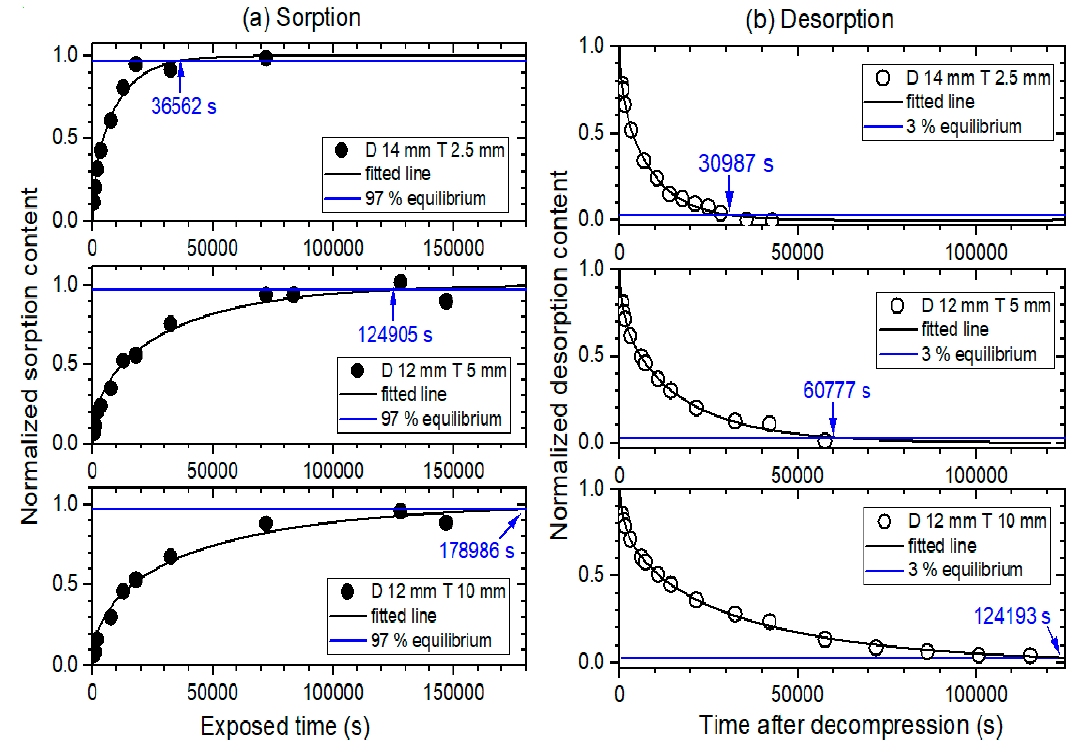
Figure 6. ( a ) Normalized sorption content versus exposed time and ( b ) normalized desorption content versus time after decompression for cylindrically-shaped NBR with a diameter of 14 mm and thickness of 2.5 mm, a diameter of 12 mm and thickness of 5 mm, and a diameter of 12 mm and thickness of 10 mm. D and T represent the diameter and thickness, respectively. The normalized sorption and desorption contents were obtained by the sequences in Figure 2a,b, respectively. The values indicated by the arrows are the equilibrium time measured in the sorption and desorption process.